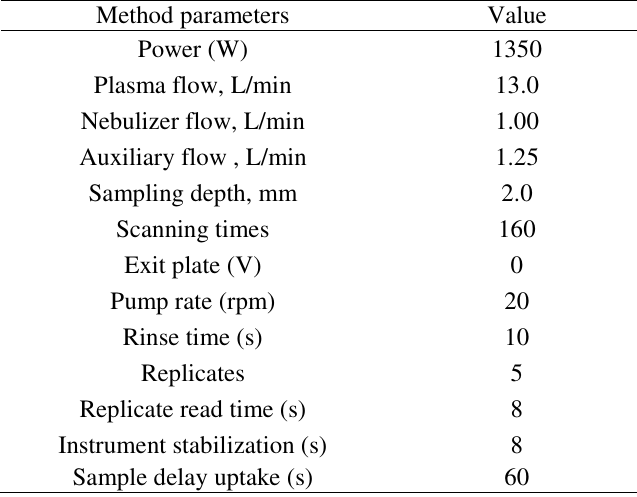
Table 2. The operating parameters for